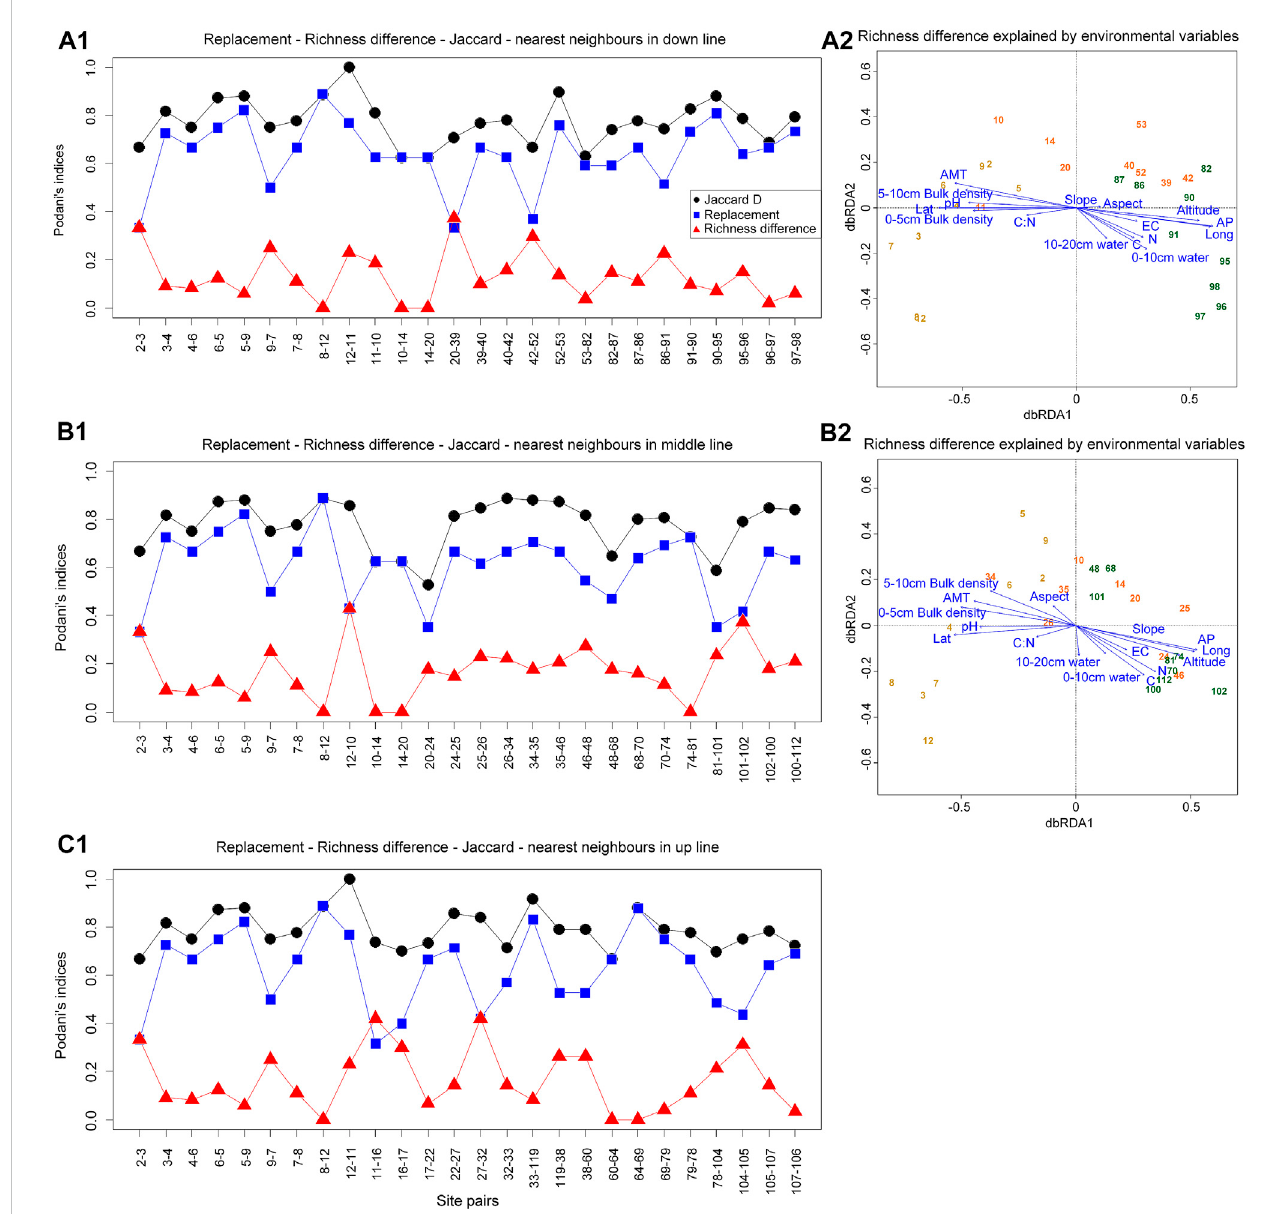
FIGURE 5 The reasons for differences among communities based on three restoration transects. C, total carbon; N, total nitrogen; EC, electrical conductivity; AP, annual precipitation; AMT, annual mean temperature; Lat, latitude; Long, longitude. The site numbers correspond to the numbers of the sampling points in Figure